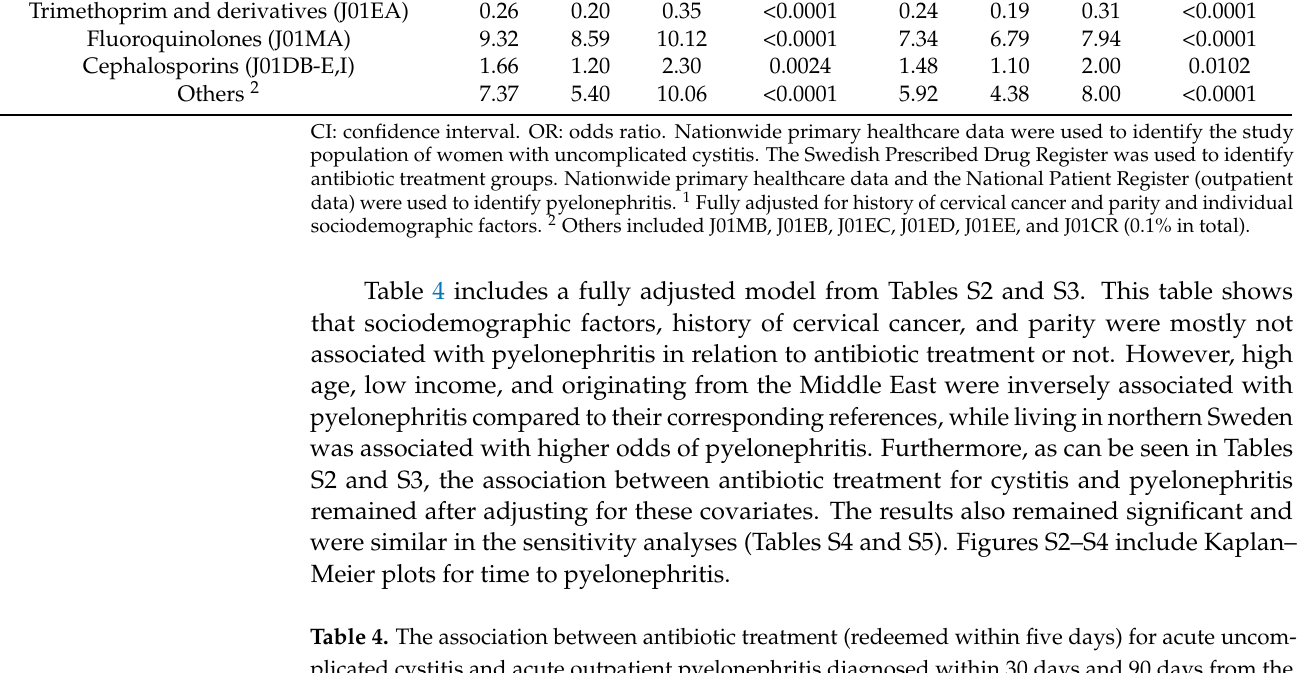
Table 3 includes the fully adjusted models on the 30-day and 90-day risk of outpatient pyelonephritis following a cystitis event in relation to antibiotic treatment or not. Antibiotic treatment was inversely associated with pyelonephritis in general, but only the three most common groups of antibiotics were inversely associated with pyelonephritis in the stratified analysis. For example, the most used antibiotic (pivmecillinam) was associated with an OR of 0.44 (95% CI 0.40 to 0.48) for pyelonephritis within 30 days from the cystitis event. Table 3. The association between antibiotic treatment (redeemed within five days) for acute un- complicated cystitis and acute outpatient pyelonephritis within 30 and 90 days from the cystitis event (2006–2018). Pyelonephritis within 30 Days Pyelonephritis within 90 Days Treatment Groups